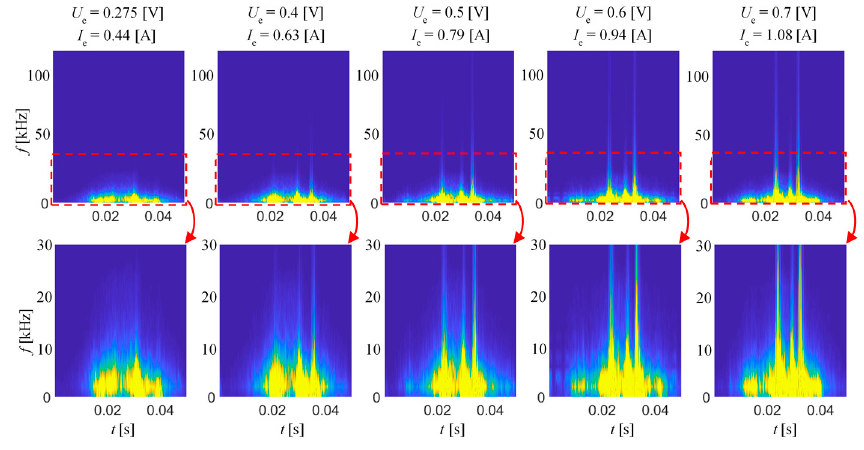
Figure 5. BN TF_S spectrograms obtained for excitation frequency of 10 Hz and various excitation voltage level.